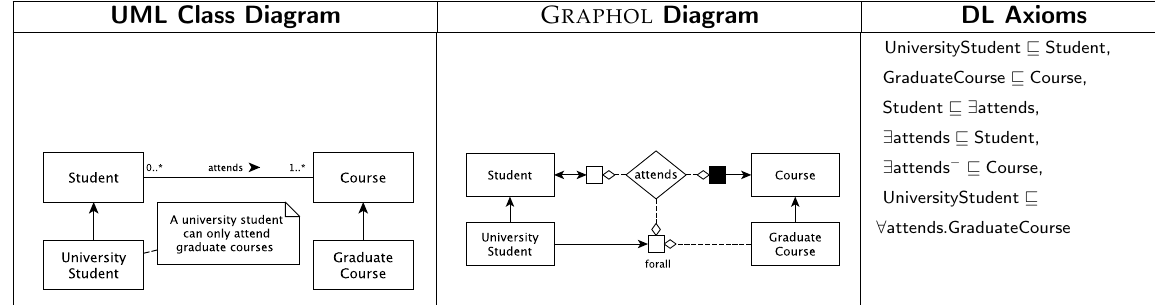
Figure 1. Introductory